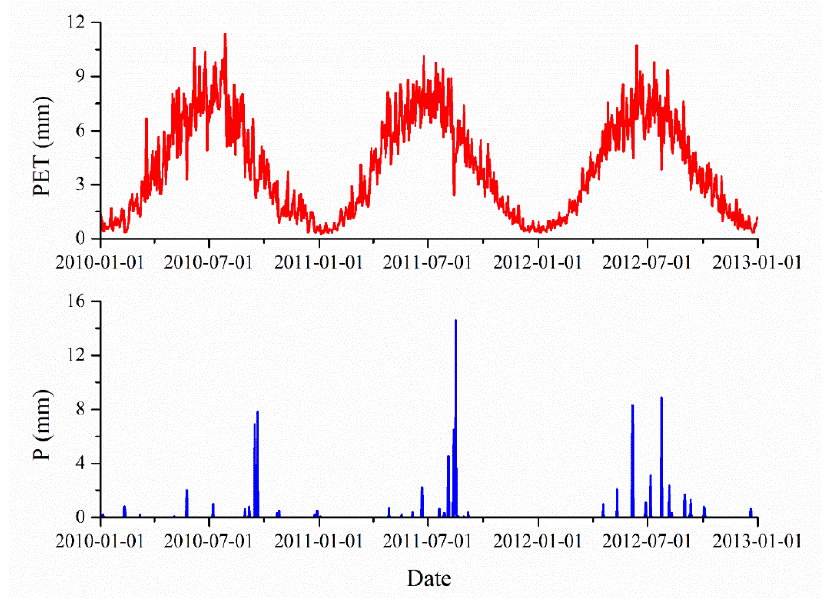
Figure 3. Daily potential evapotranspiration (PET, mm) and precipitation (P, mm) at the Ejina meteorological station.